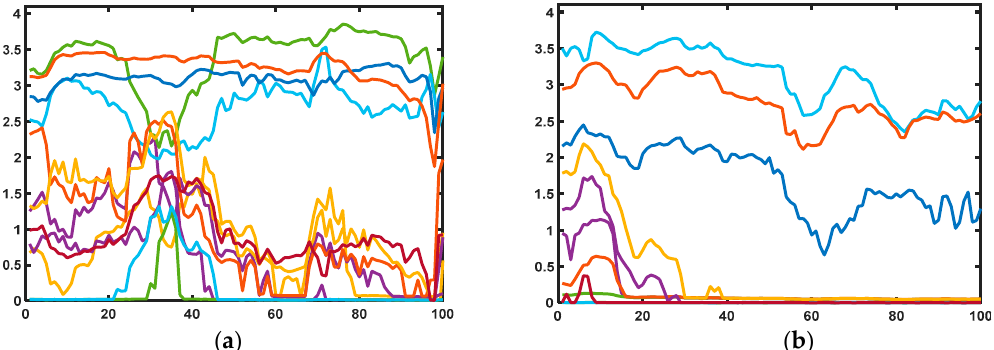
Figure 4. A glimpse of 16-channel FMG signals: ( a ) normal pHRI training data, ( b ) unsafe pHRI test data.